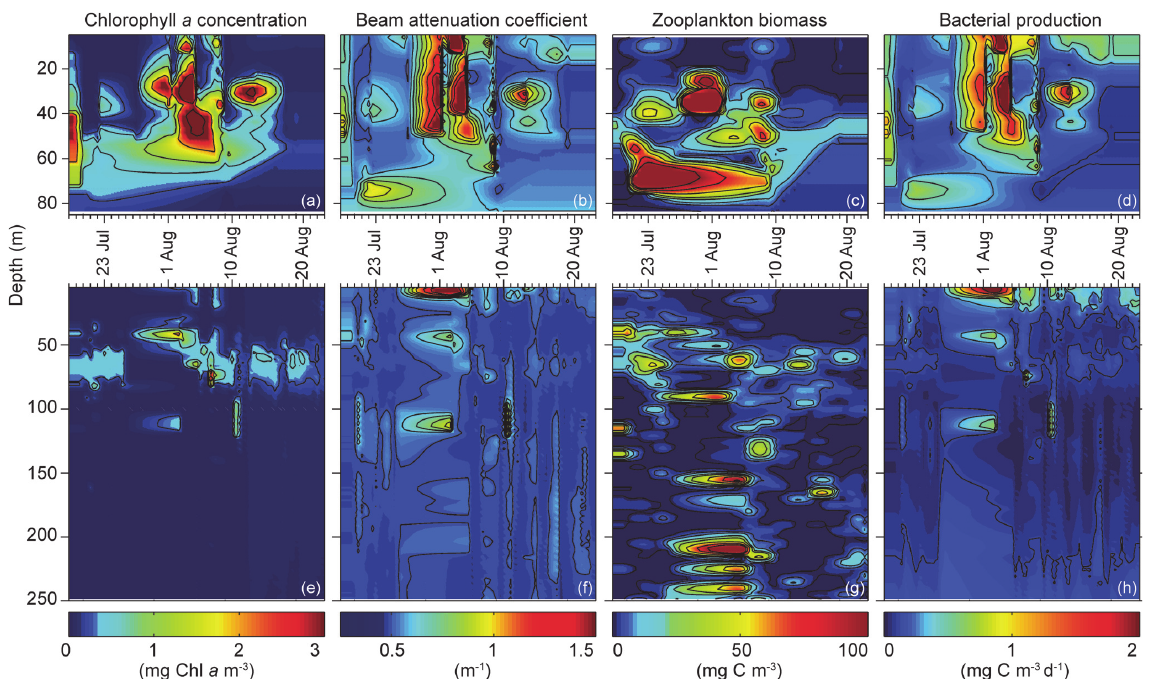
Fig. 12. Times-series from 18 July to 23 August 2009 of biological/optical parameters measured inshore (top panels) and offshore (lower panels) during the ArcticNet-Malina campaign. Each panel corresponds to an interpolated composite (Delaunay) using all the stations located within or beyond the 100m isobath, which delimits the inshore vs. offshore zones. See Sect. 2.5 for an exhaustive description on the acquisition and analysis of each parameter. Further information on the zooplankton biomass is given in Fig.